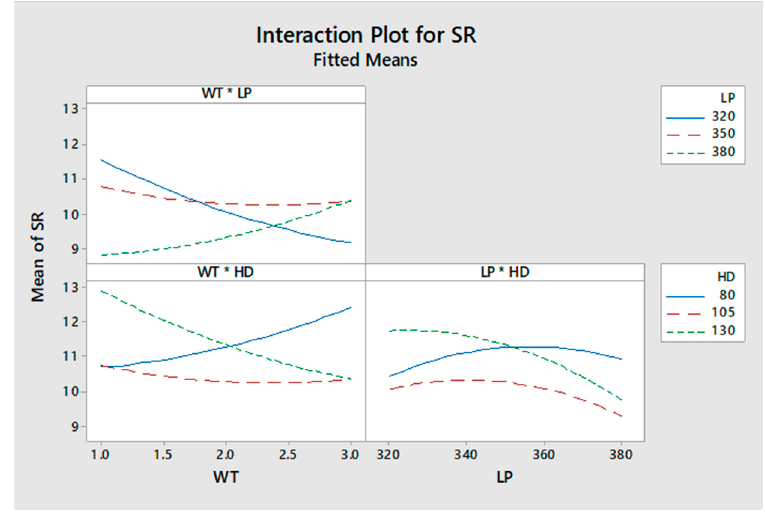
Figure 8. Interaction plot for SR.